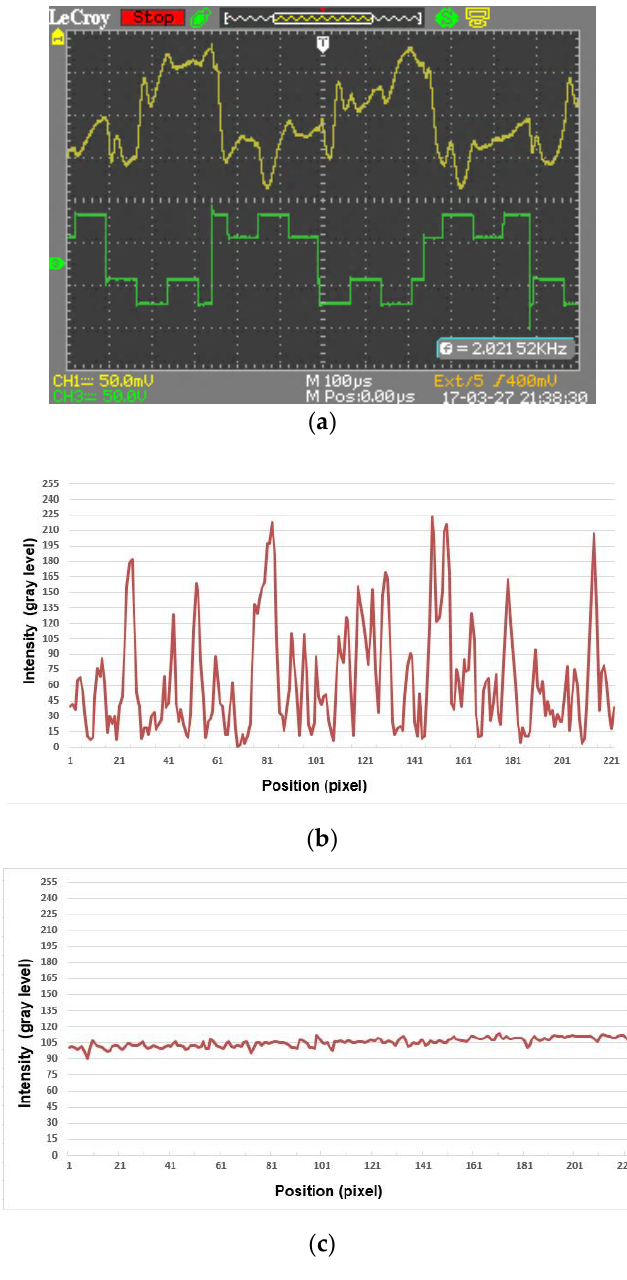
Figure 15. Illustration of the operation of an experimental sample of a despeckler using the novel helix-free FLC: ( a ) Oscillograms of the control voltage (zero level — digit 3) and phase delay modulation (zero level — digit 1); value of a low-frequency signal (meander) 2 kHz and amplitude ±50 V; frequency of the modulating signal is 7 kHz and amplitude ±15 V; electric field strength is 3.25 V/μm; ( b ) Radiation intensity distribution in the cross section of a laser beam transmitted through the electro-optical despeckler sample when the control voltage is zero; contrast of the speckle pattern C 0 = 0.82; ( c ) Radiation intensity distribution in the cross section of a laser beam in the presence of the control voltage; contrast of the speckle pattern C 1 = 0.07. The thickness of the FLC cell is 20 µ m. The wavelength of the laser radiation is 0.65 μm.